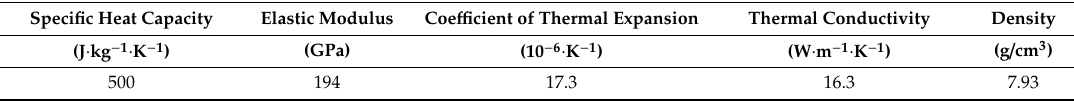
Table 2. Physical properties of AISI 304 austenitic stainless